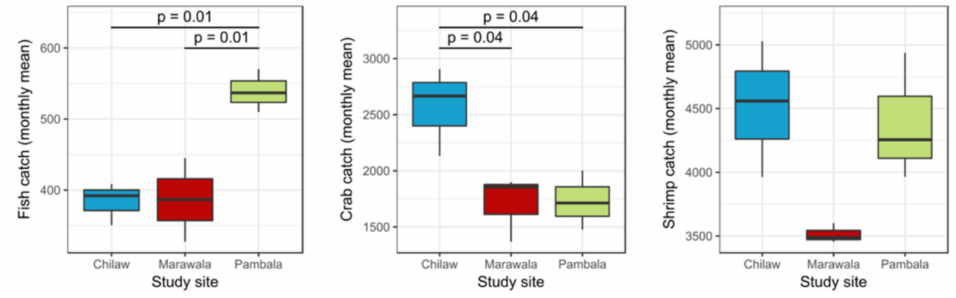
Figure 3. Mean monthly fishery catches in the three study sites, separated by fish ( left ) crab ( middle ) and shrimp ( right ) species. Significant differences between sites (following the Tukey post-hoc test) are indicated at the top of each